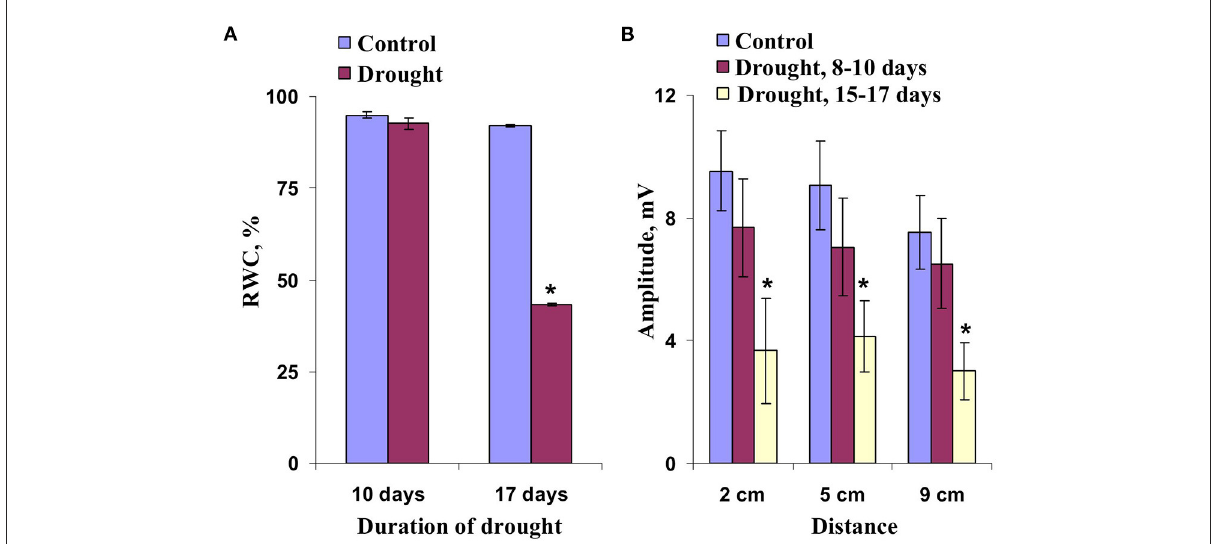
FIGURE5 Dependence of the relative water content (RWC) in wheat leaves on duration of the soil drought ( n = 5–9) (A) and dependence of the amplitude of hyperpolarization electrical signals on distance from the zone of the local action of combination of illumination and heating under control and drought conditions ( n = 5–11) (B) . The soil drought was provided by termination of irrigation of plants. *, values were significantly differed from ones in the control ( p < 0.05). Vertical bars represent standard